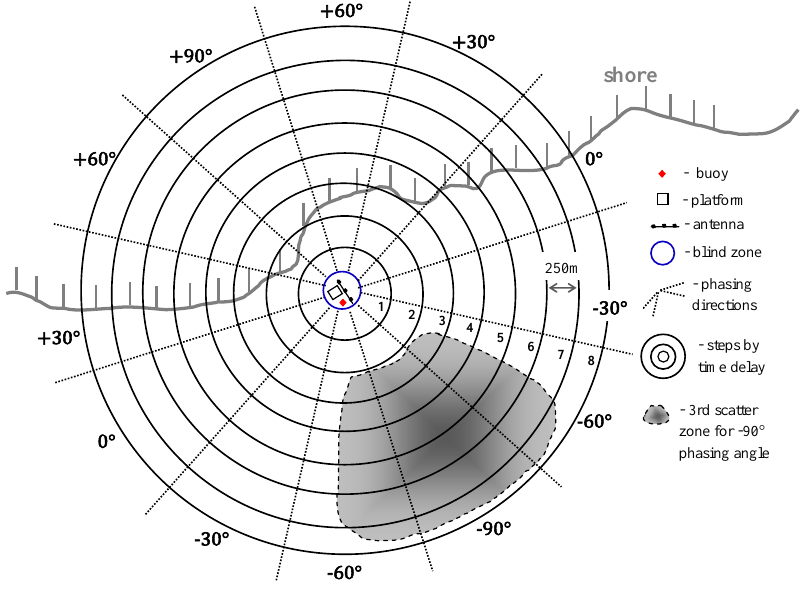
Figure 2. Experimental scheme, top view, phasing and time strobing grid. An example of approximate scattering region delineated for a pulse length of 2 s.